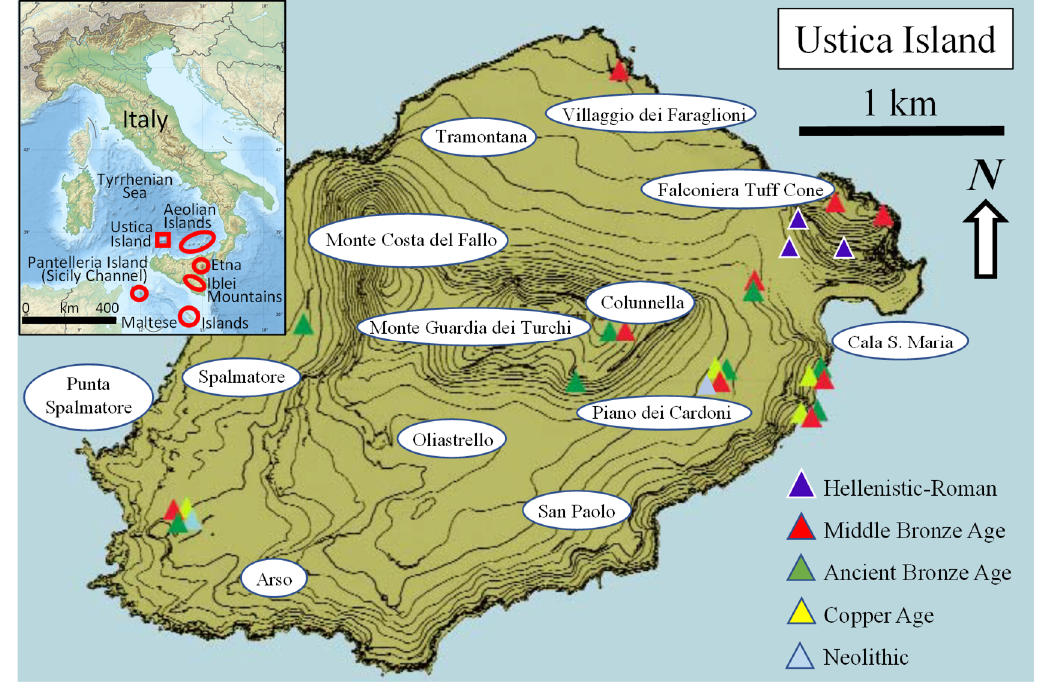
Figure 2. Ustica Island with the location of the most important archaeological sites (from [35], modified).